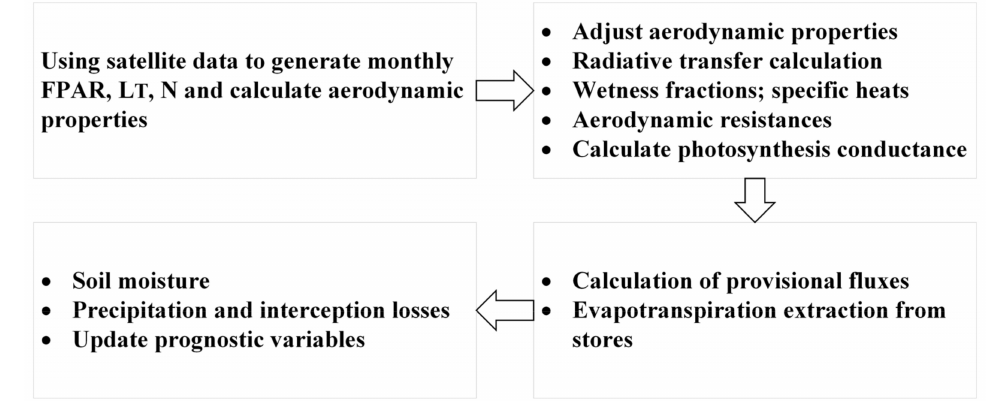
Figure 3. The simulation process of